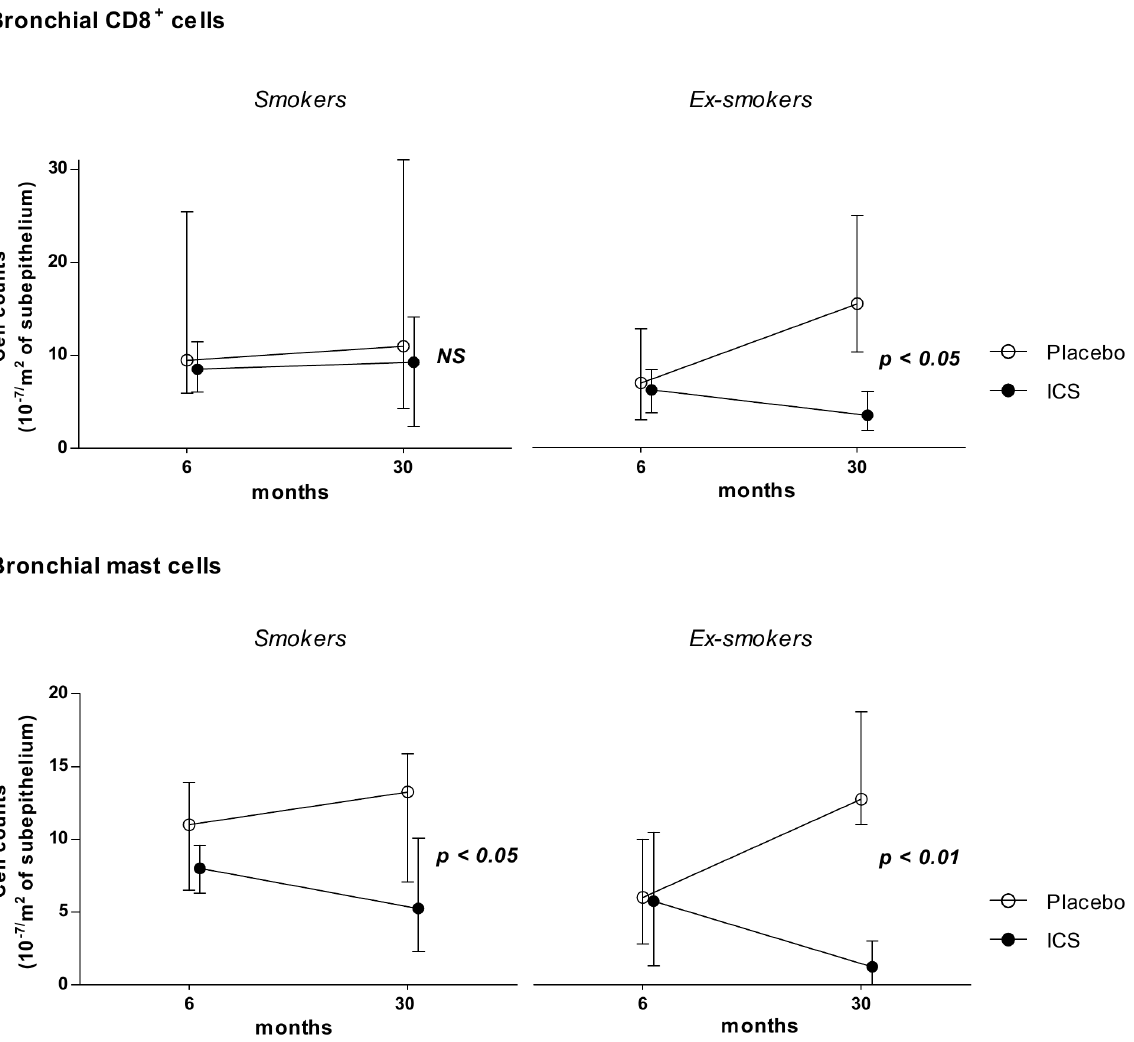
Figure 1. Effects of long-term ICS treatment on CD8 + cells and bronchial mast cells. Effects of ICS treatment from 6–30 months in persistent smokers and persistent ex-smokers on bronchial CD8 + cells (upper panel) and bronchial mast cells (lower panel). Data are presented as medians (Interquartile Ranges). NS=not significant.